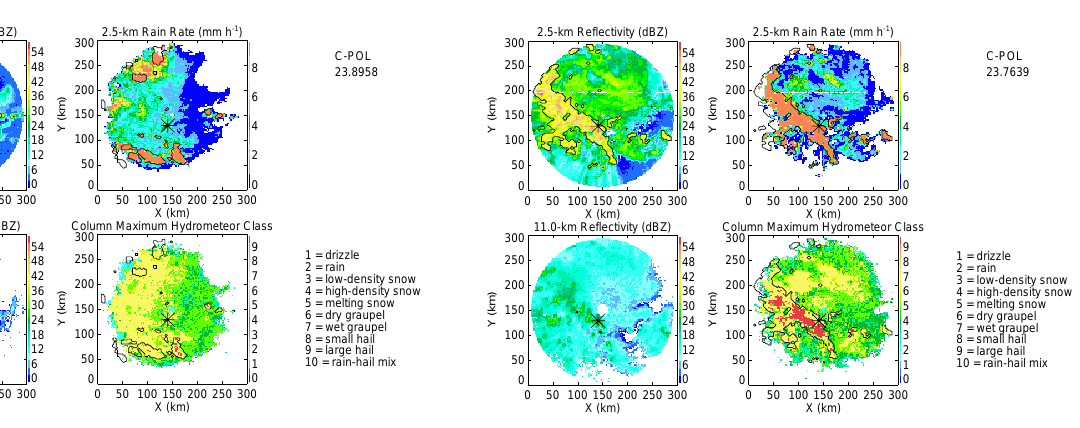
Figure 14. Same as Fig. 13 except when the S-band experienced convective rain at